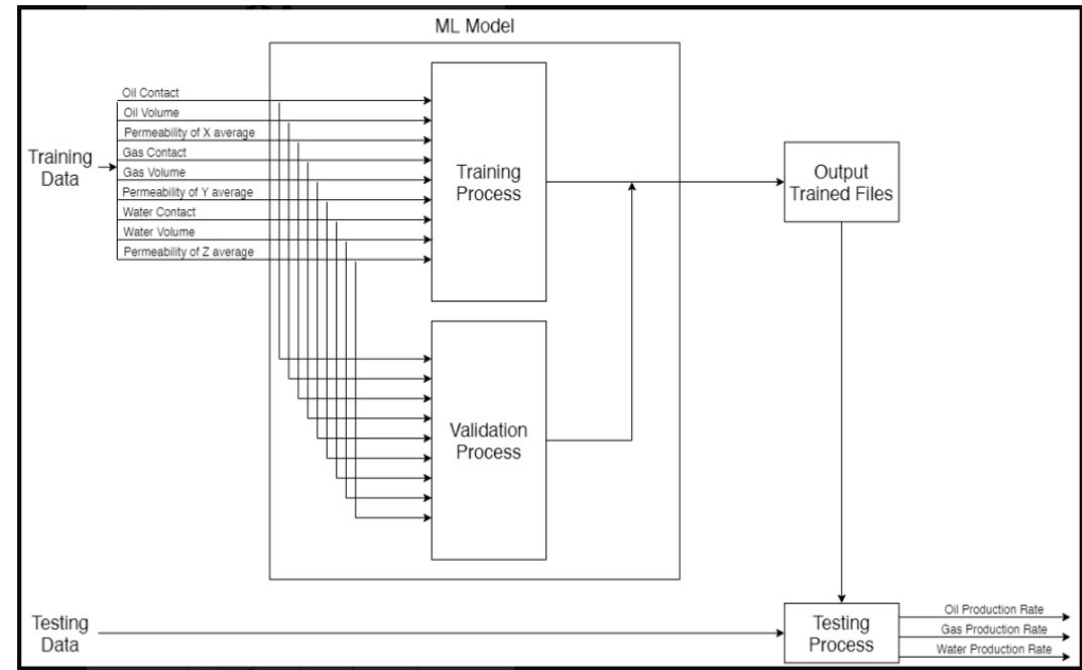
Figure 3. AI Model.